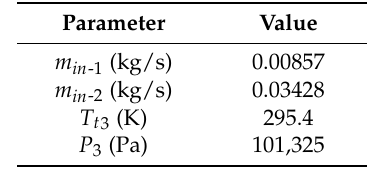
Table 2. Operating conditions of four-point LDI combustors.